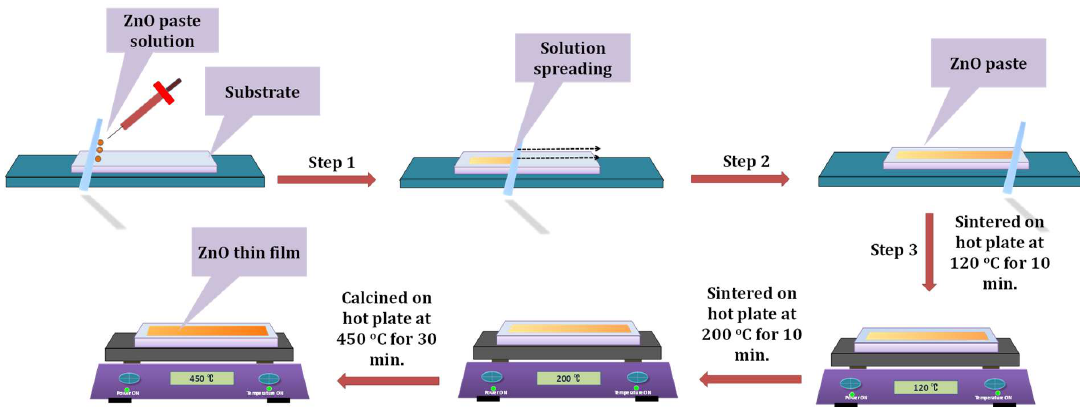
Figure 2. Schematic representation of the doctor blade deposition technique for the development of the ZnO thin film.